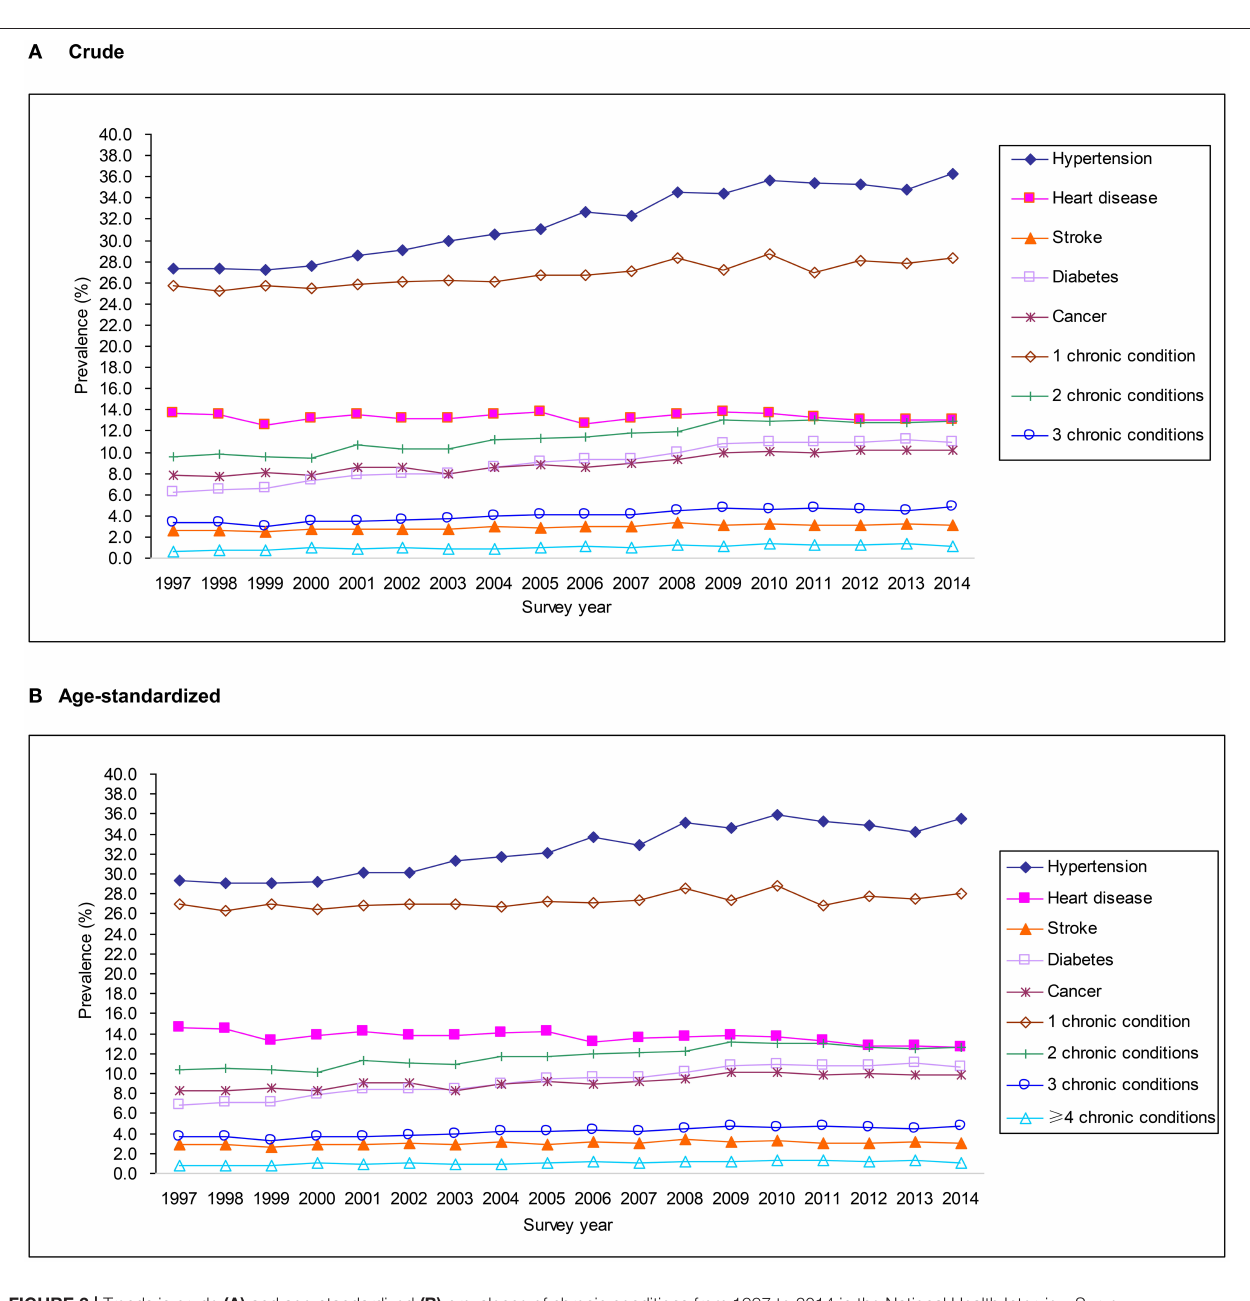
Frontiers in Cardiovascular Medicine |